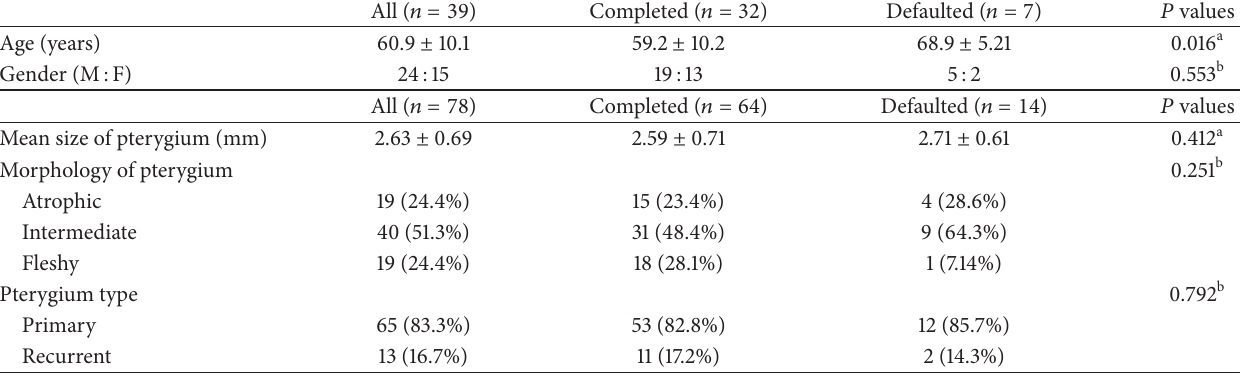
Table 1: Demographic and Clinical Data of Patients with double head pterygium.